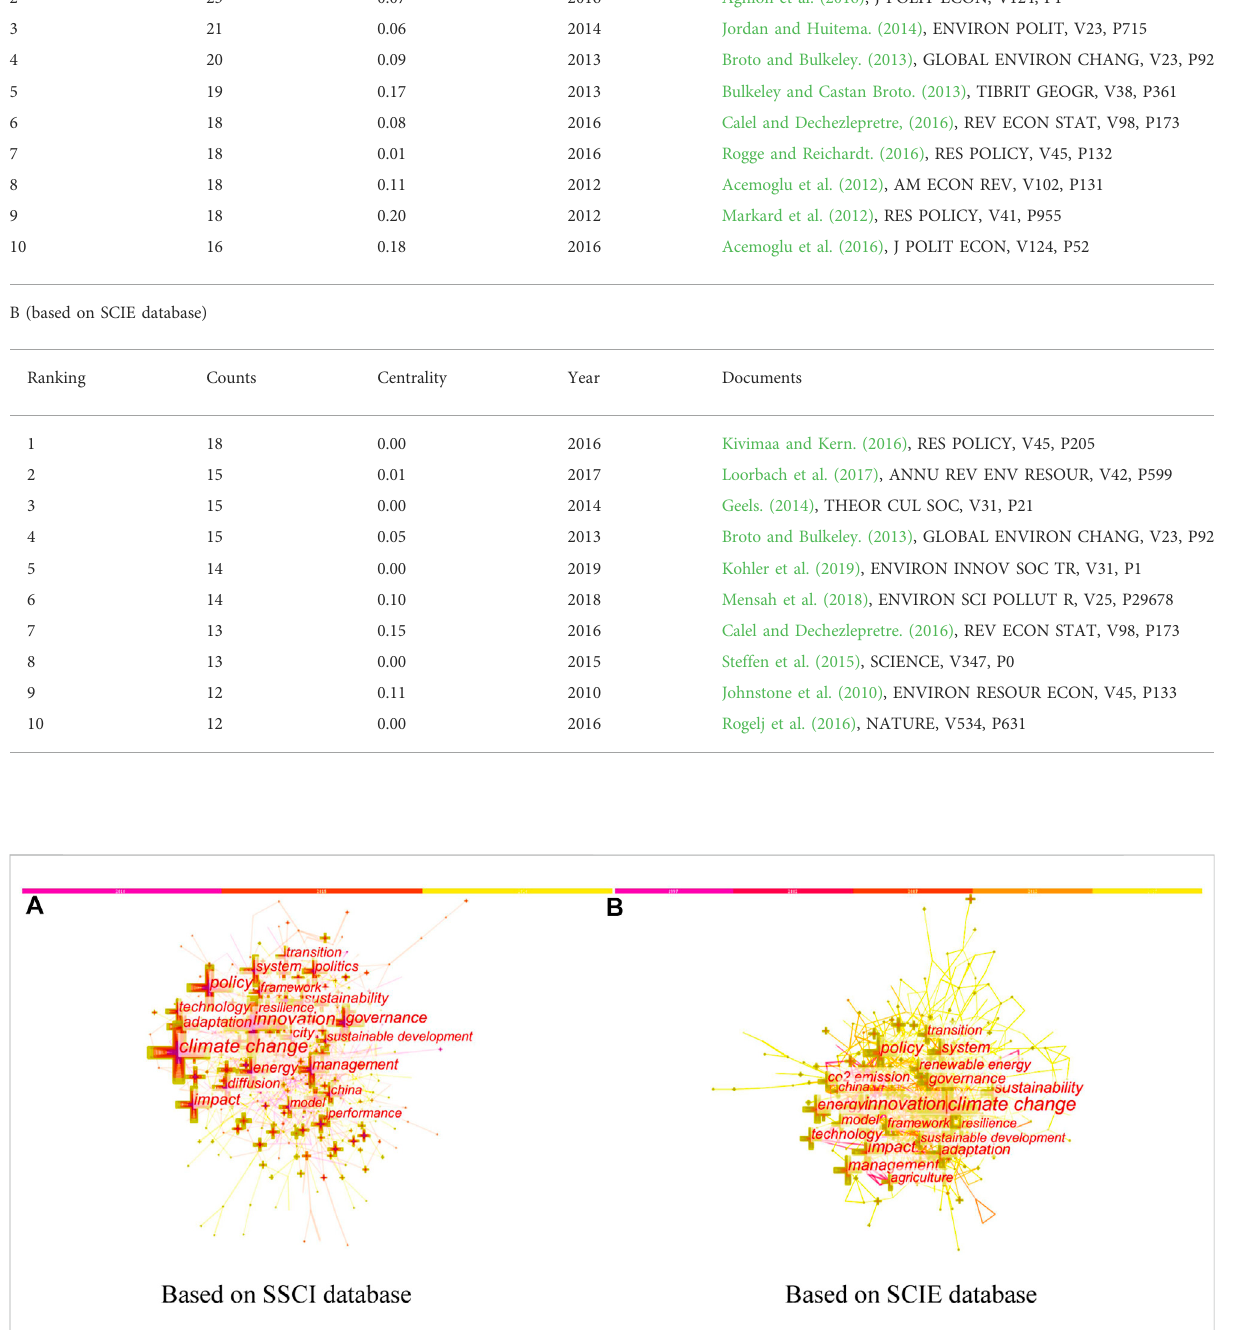
FIGURE 7 Map of the keywords co-occurrence network of climate change innovation research. (A) refers to the SSCI database and (B) refers to the SCI